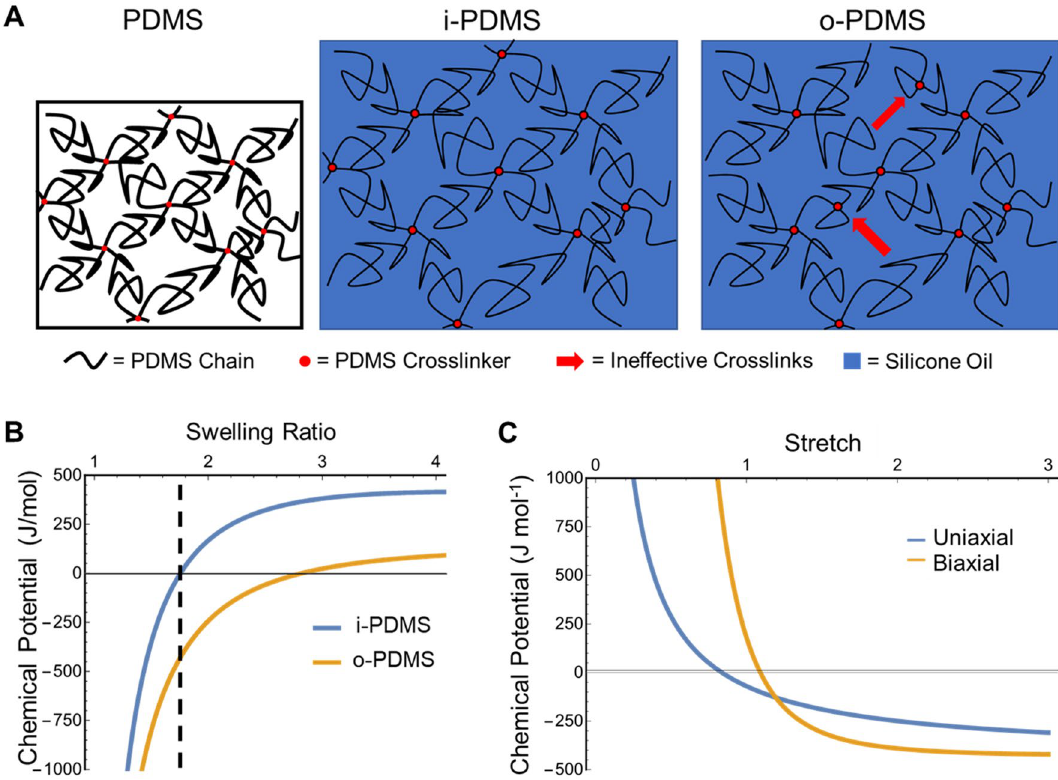
Figure 7. Flory–Rehner theory applied to the properties of o-PDMS and i-PDMS. ( A ) Idealized depictions of the difference in structure between i-PDMS and o-PDMS. Black lines represent the PDMS network, red dots indicate crosslinks, and the blue background represents the swelling oil. o-PDMS contains a high number of self-crosslinking, highlighted by red arrows. ( B ) Graph of the theoretical chemical potential of oil as a function of the swelling ratio. The dashed black line indicates the equilibrium swelling ratio of i-PDMS and the equivalent composition of the as-prepared o-PDMS. The o-PDMS has a large negative value for the chemical potential at